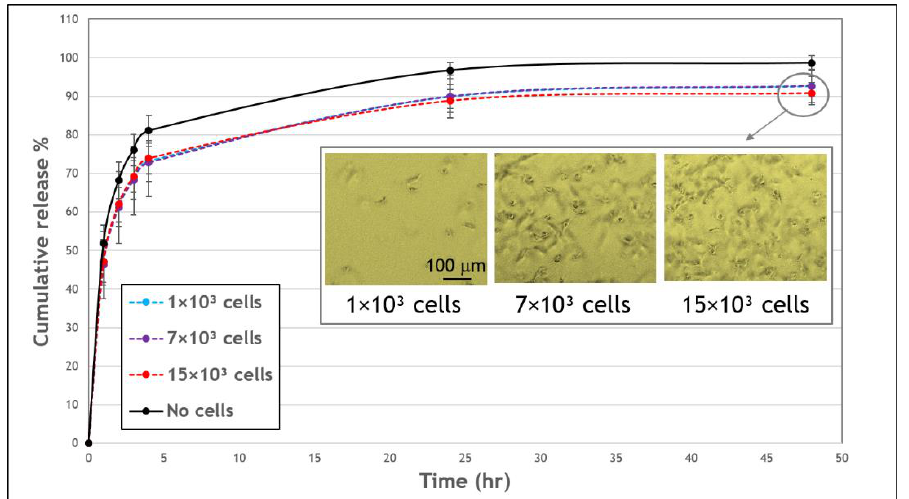
Figure 6. The effect of human umbilical vein endothelial cells (HUVECs) on the cumulative release profile of FD 250 kDa from fibrin gels. Gels embedded with 1 × 10 3 (blue, dashed line), 7 × 10 3 (purple, dashed line), 15 × 10 3 cells (red, dashed line), or without cells (black, continuous line). No statistically significant difference was noted in FD release profiles from gels with compared to without cells over the 48-h observation period ( p < 0.05). The values represent the mean ± SD of 8 gels. Insert shows images of HUVECs embedded in fibrin gels, after a 48-h incubation. Scale bar is 100 µ